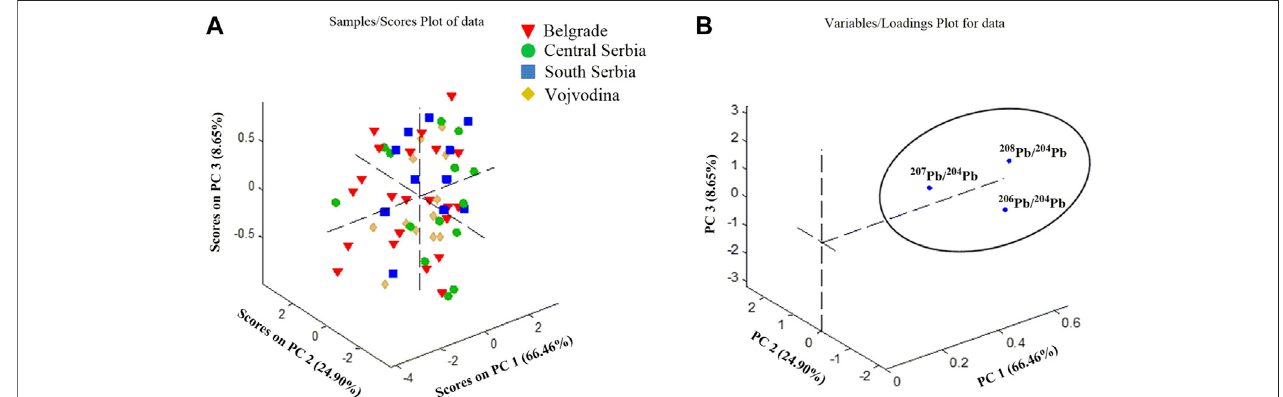
FIGURE 5 | The map of Republic of Serbia according to the type of soil ( Č akmak et al., 2018).